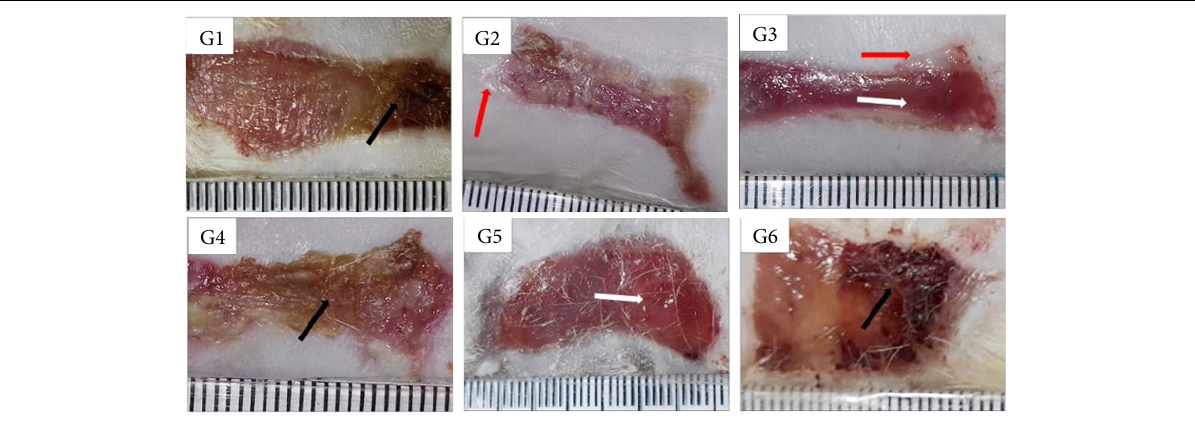
Black arrow – necrosis/crust. White arrow: granulation tissue. Red arrow: reepithelialization. Scale in mm. Figure 2 - Macroscopic aspects of partial thickness burn wounds experimentally induced in Wistar rats treated with silver-based dressings through 14 days.